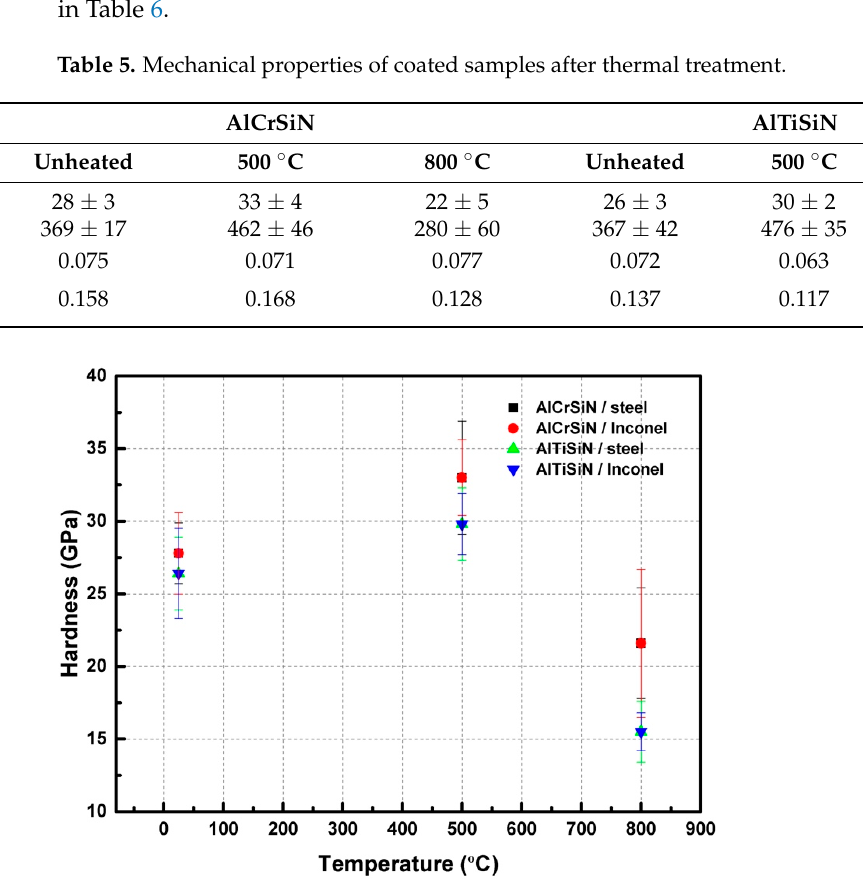
Table 6 . Vickers hardness of the substrates .